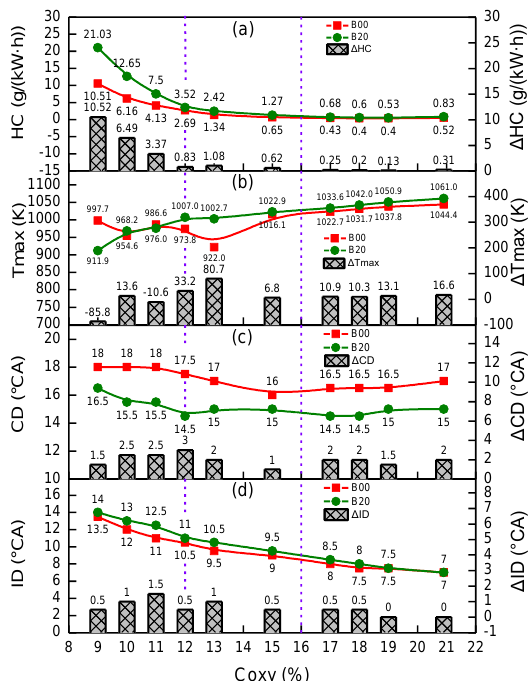
Figure 3. HC emissions and the difference ( a ), maximum in-cylinder temperatures and the difference ( b ), combustion durations and the difference ( c ), and ignition delay periods and the difference ( d ) for B00 and B20 fuels.